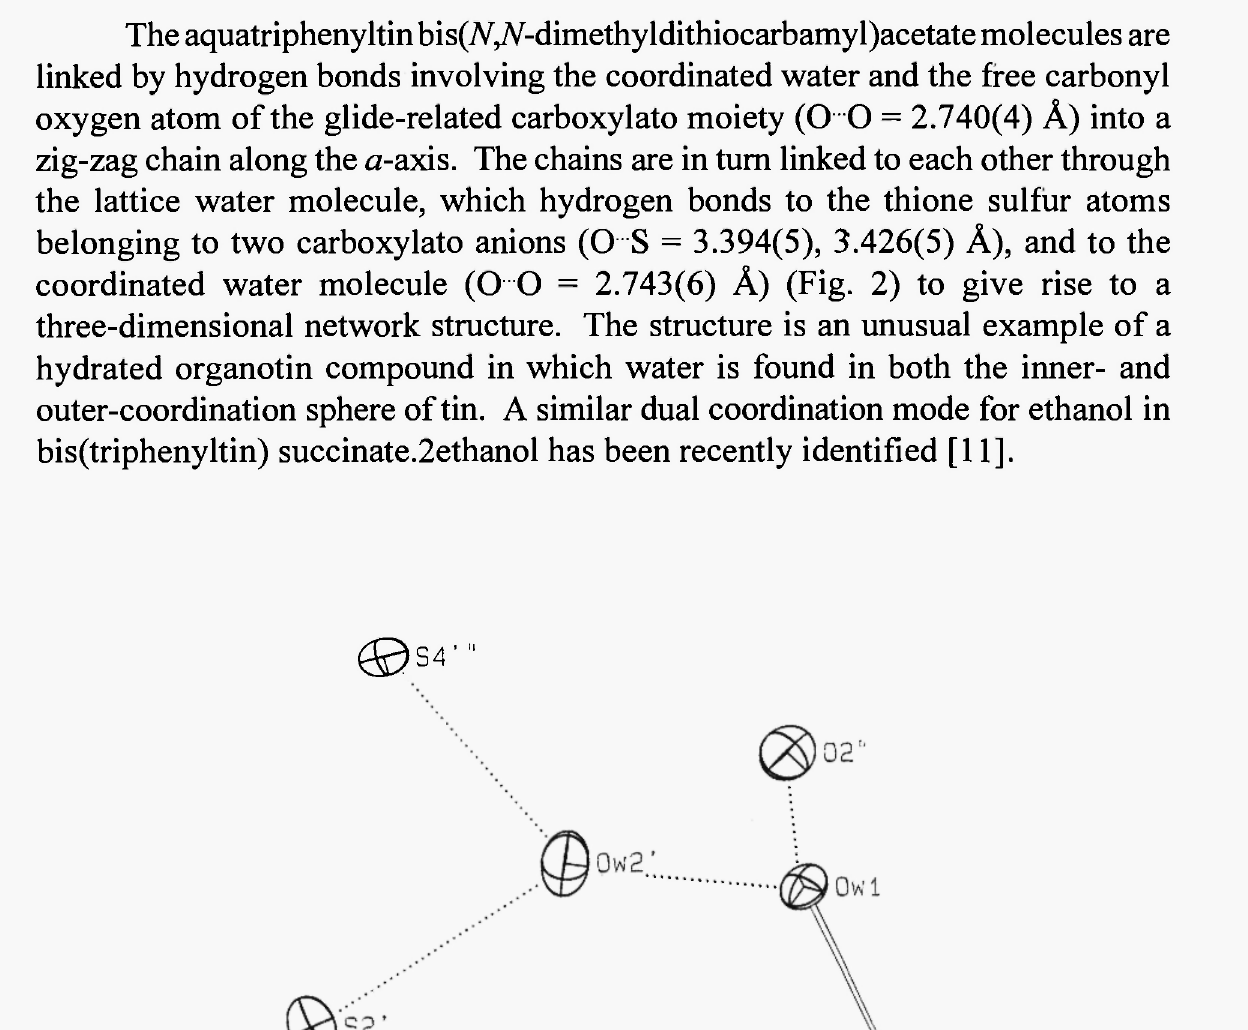
Fig. 2. Coordination of water to tin. Bond distances and angles: S2 Ow2 = 3.394(5), S4'" Ow2' = 3.426(5), 02" Owl = 2.740(4), OwlOw2' = 2.743(6) A; Snl-Owl 02" = 137.15(6), Snl Owl Ow2' = 113.68(8), 02" Owl Ow2' = 93.80(8), S2' Ow2' S4'" = 88.60(8), S2' Ow2' Owl = 123.1(1), S4'" Ow2' Owl = 138.5(1)°. Transformation codes: (') -χ, 1 - y, 1 - z; (") χ - Vi V - y, z; ('") χ - 1, y, 2